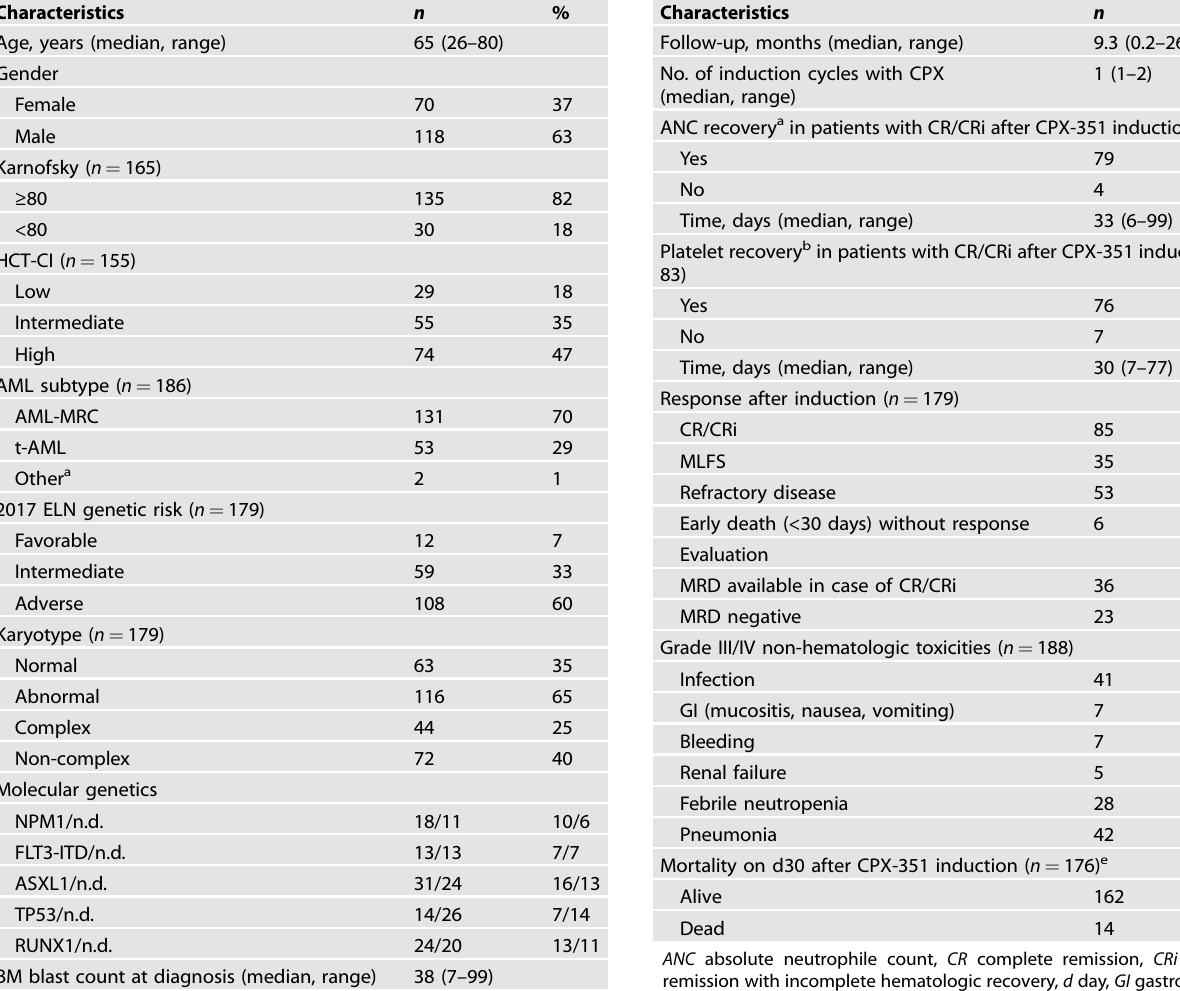
Table 2. Treatment characteristics, response, and toxicity. Table 1. Patient characteristics ( n =